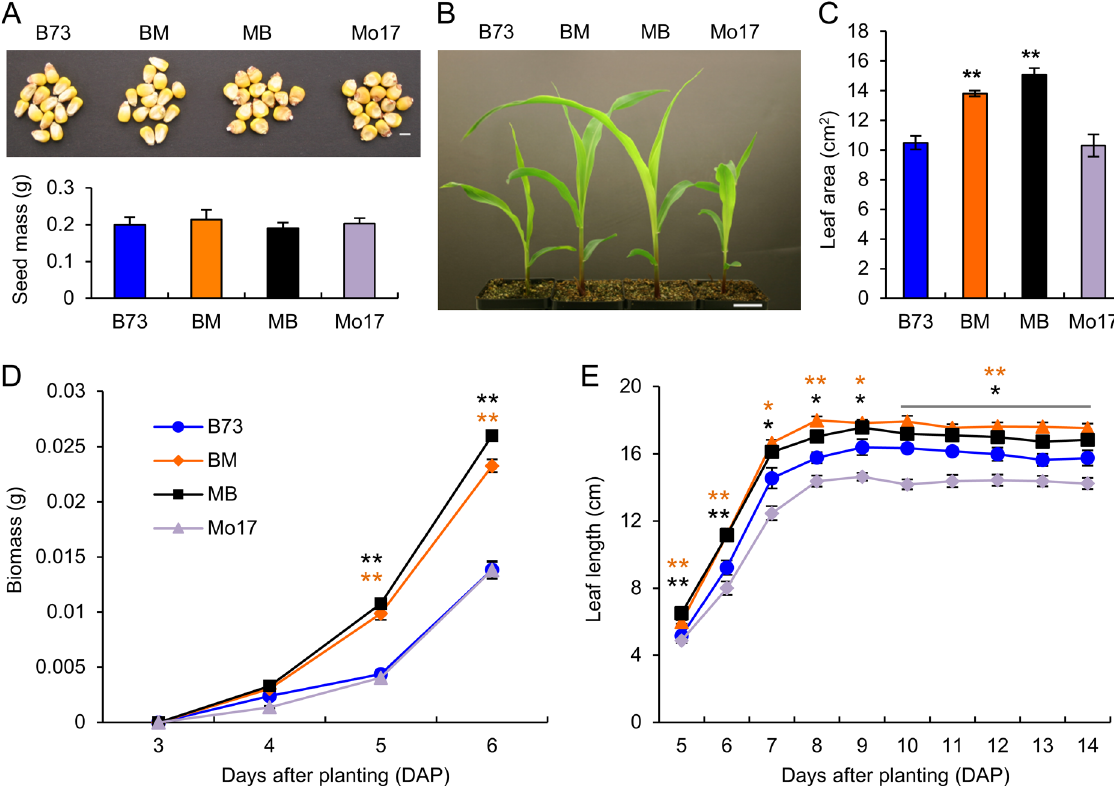
Fig 1. Growth heterosis starts at the early seedling stage. (A) Seed morphology (upper panel) and weight (lower panel, means ± SEM) in maize inbred lines (B73 and Mo17) and their reciprocal F1 hybrids (B73XMo17, BM and Mo17XB73, MB). Scale bar = 10 mm. (B) Seedling phenotypes showing growth vigor in maize F1 hybrids. Scale bar = 10 mm. (C) Leaf area of F1 hybrids relative to the inbreds (means ± SEM, n = 10). (D) Growth curve of biomass in the maize inbreds and F1 hybrids (means ± SEM, n = 6). (E) Growth curves of leaf length in the maize inbreds and F1 hybrids (means ± SEM, n = 5). Heterosis for biomass and leaf length was observed at 5 DAP in the hybrids. Note that the earliest time to measure biomass was 3 DAP when young leaves emerged. Significant difference between hybrids and the best parent was calculated using Student ’ s t-test, * p-value < 0.05 and ** p-value <